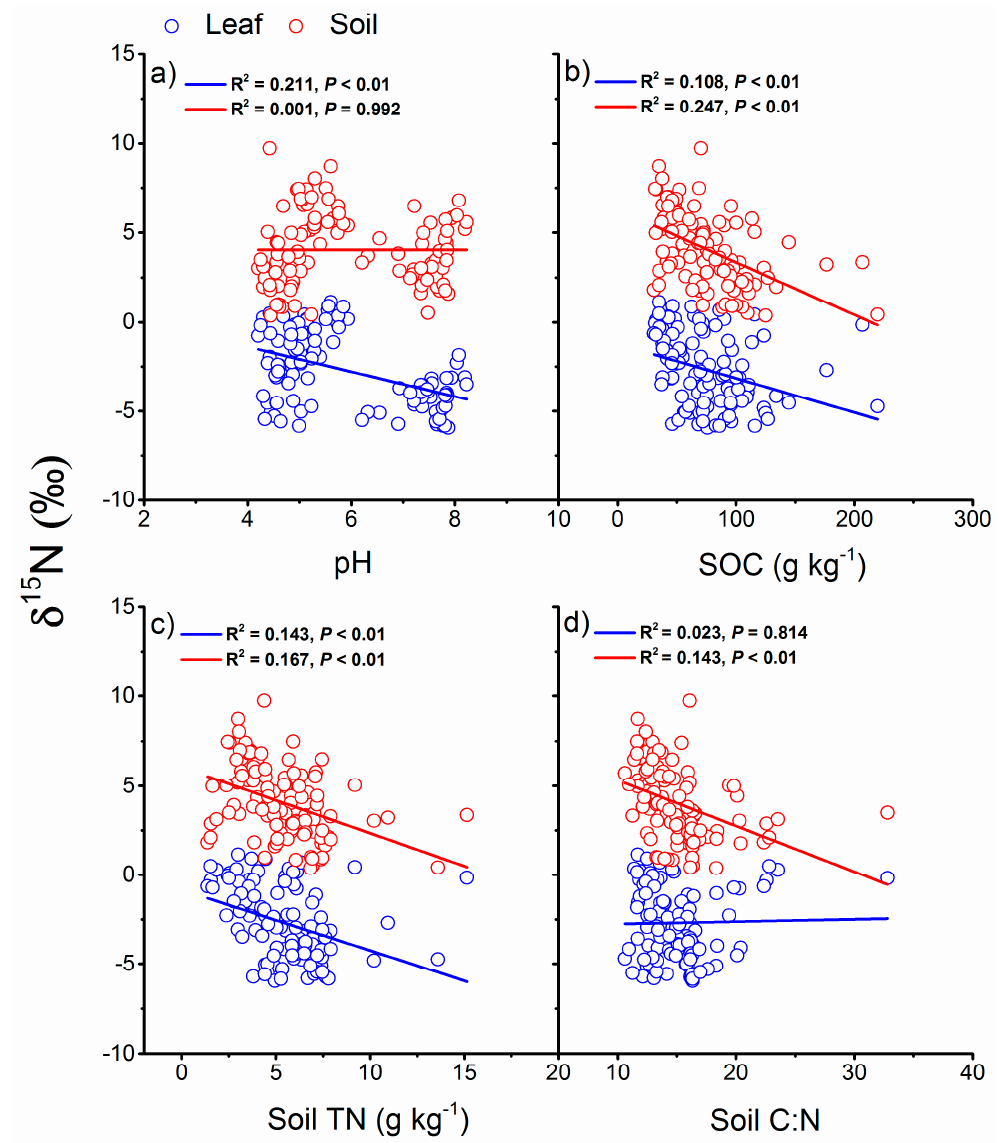
Figure 5. Relationships of δ 15 N in leaves and soils and soil physicochemical parameters across three sampling sites. Table 3. Correlation analyses ( R values) of leaf δ 15 N and soil δ 15 N with leaf N and soil physicochemical parameters for each sampling